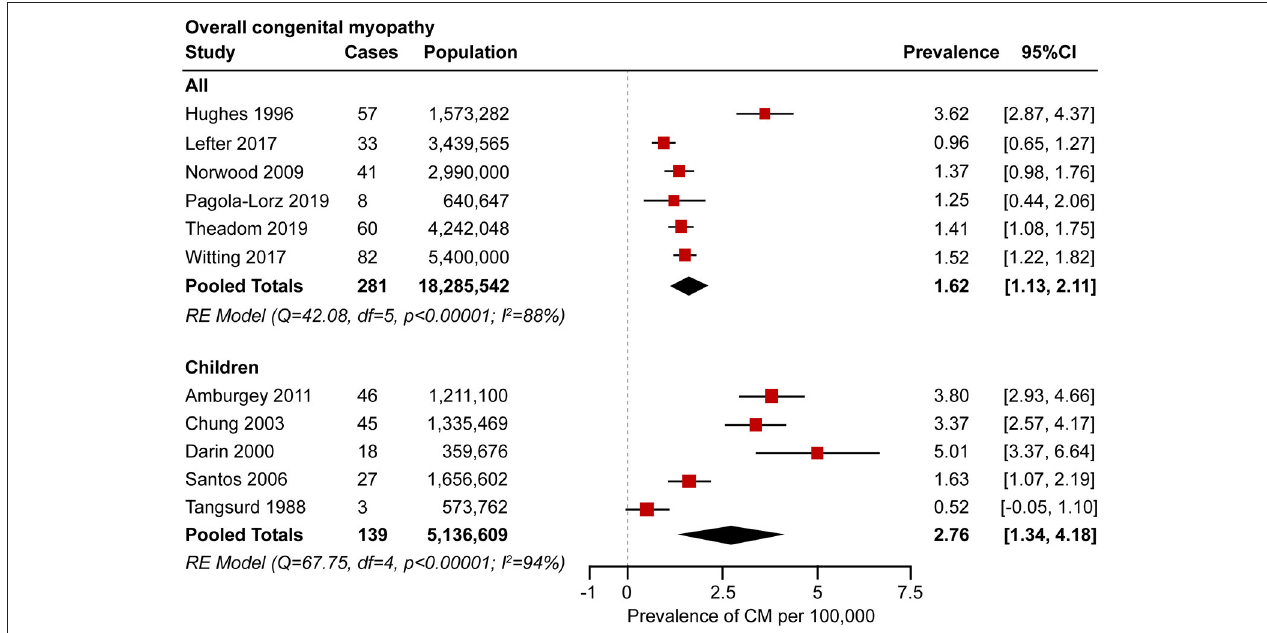
FIGURE 2 | Forest plot of the estimated prevalence of congenital myopathy per 100,000 cases along with the 95% confidence interval (CI).